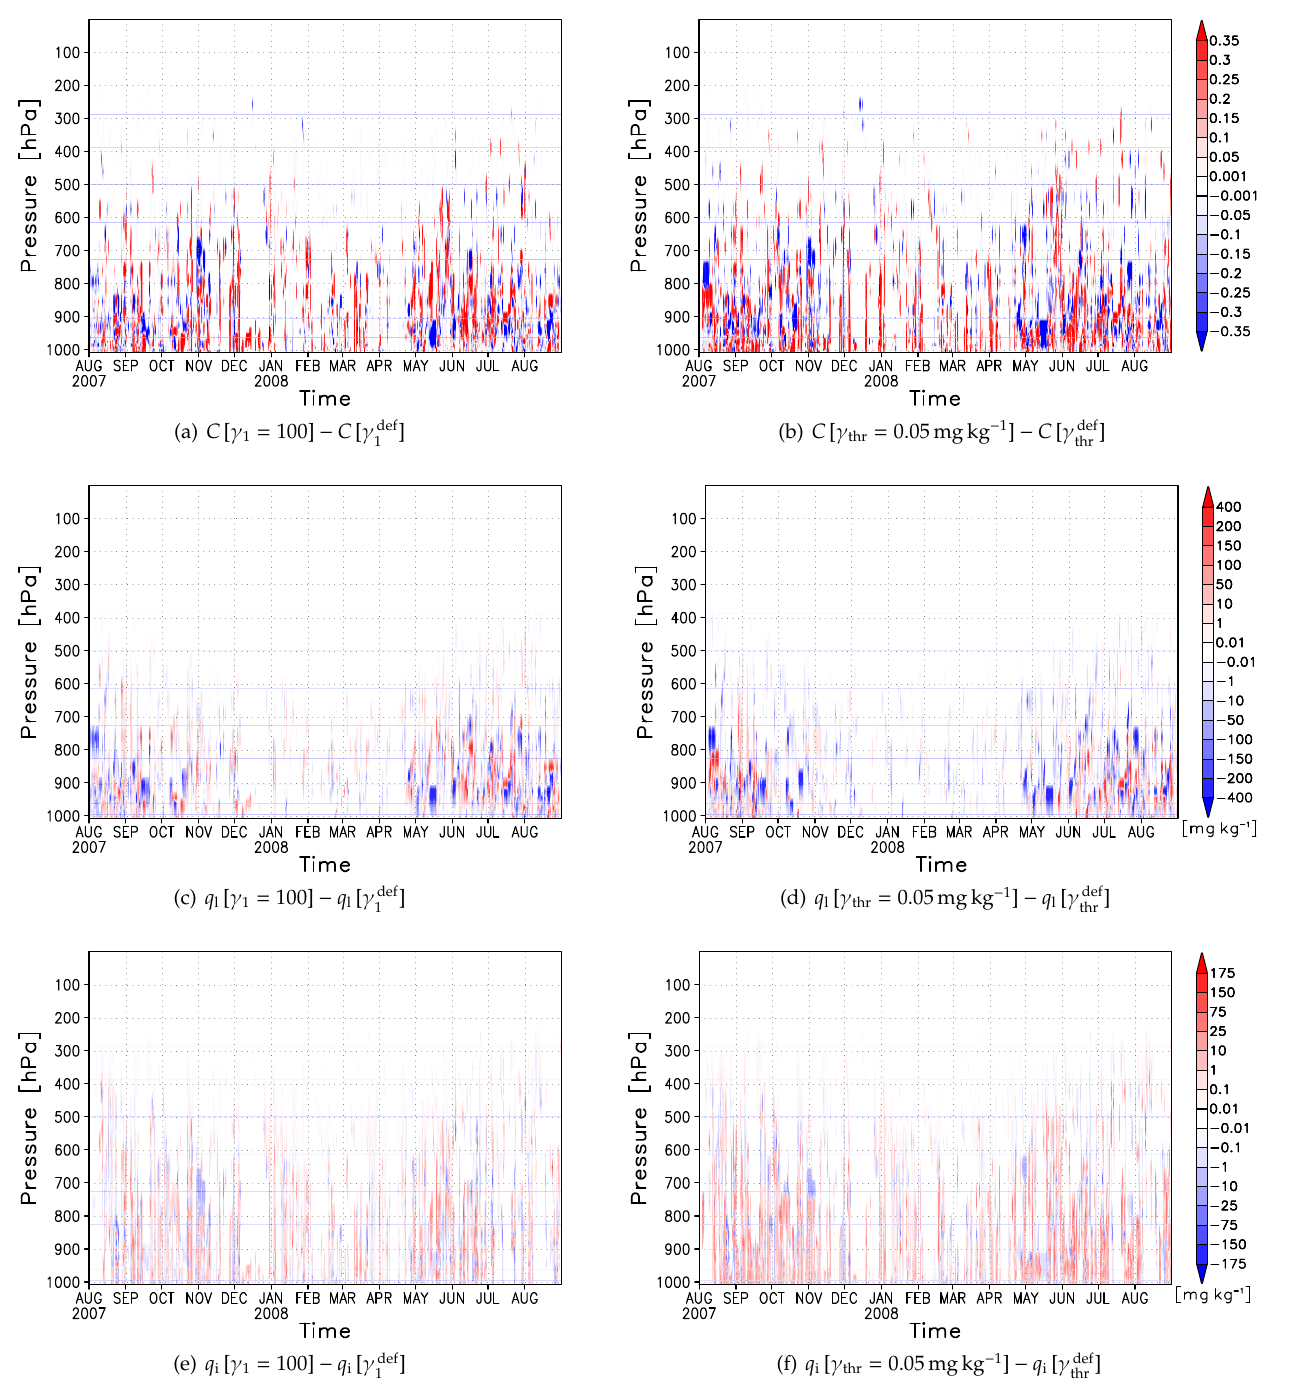
reduction of LWP but rise in IWP . While C tot decreases and P tot remains almost unchanged, P increases overall. Figure 6. Difference plots (SENS minus CTRL) of simulated fractional cloud cover ( top ), cloud water content ( middle ), and cloud ice content ( bottom ) for one higher value of the tunable parameter γ ( left column ) and one lower value of the tunable parameter γ 1 column ), with γ def = 0 . 5 mg kg − 1 . These sensitivity experiments were = 15 and γ def 1 thr conducted at the NP-35 start position simulating from 1 August 2007 to 31 August 2008 by analogy to the reference run (Figure